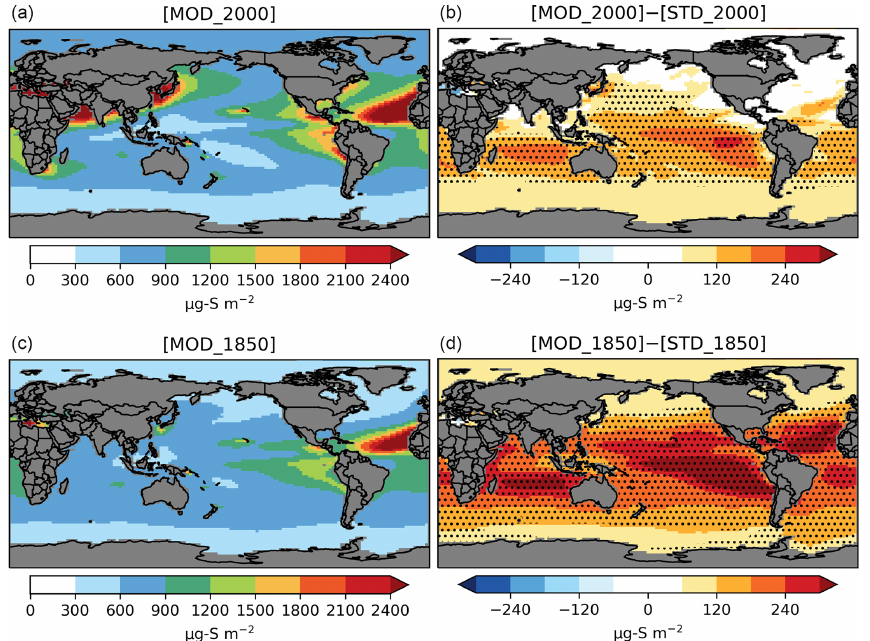
Figure 5. Spatial distribution of annual mean column concentrations (µgSm − 2 ) for sulfate aerosol simulated by [MOD] (a, c) and their dif- ference from the baseline run (b, d) . Only values over the ocean are shown. Dotted regions indicate where statistically significant differences are identified by grid-by-grid two-sample t tests with p values < 0.05.